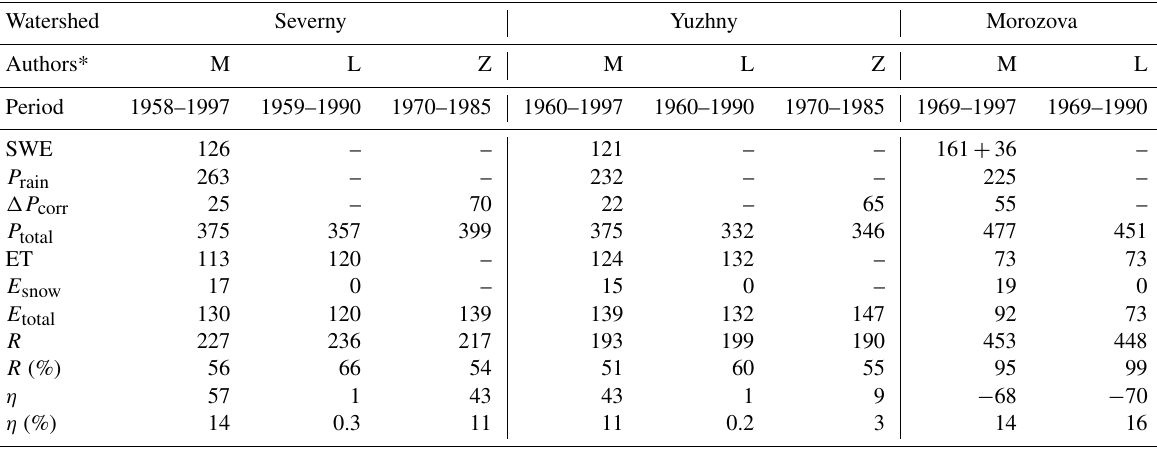
Table 8. Water balance of the three micro-watersheds of the KWBS (mm, %). Watershed